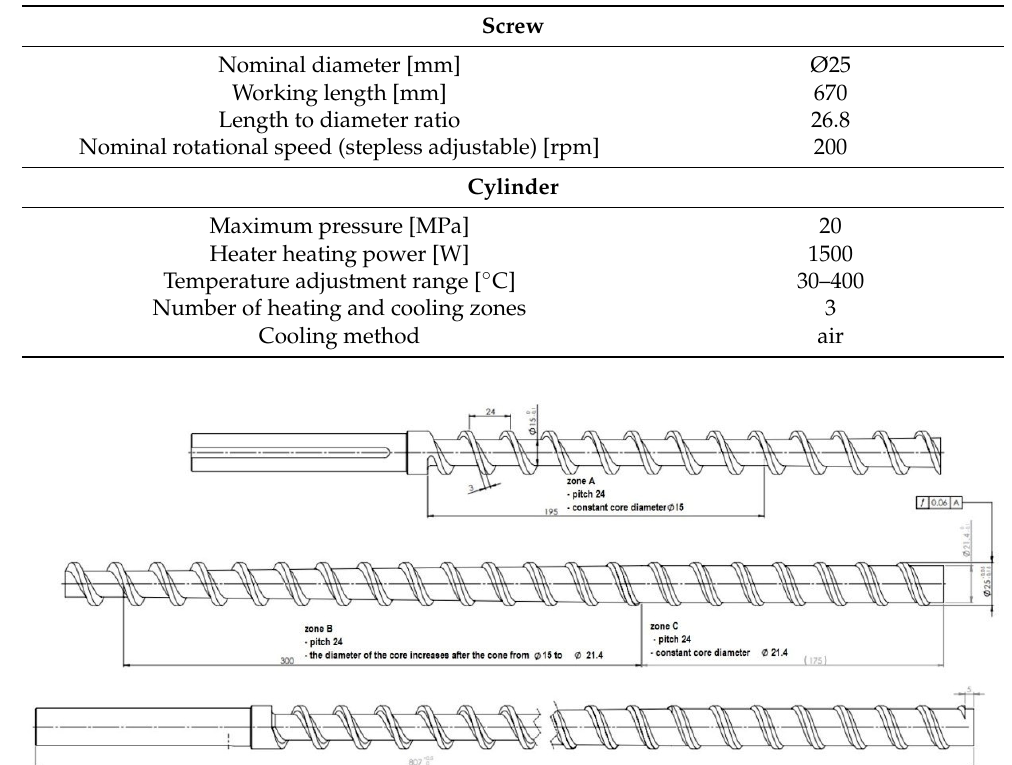
Figure 3. The extrusion line of PHBV- plant origin fiber biocomposites: 1—ZAMAK EHP-25E ex- truder, 2—cooling bath, 3—granulators. Table 3. Technical data of the ZAMAK EHP-25E extruder (based on [29]). Table 3. Technical data of the ZAMAK EHP-25E extruder (based on [29]).